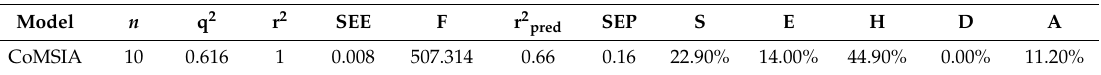
Table 3. Evaluation parameters and molecular field contribution rate of PAEs’ flammability, biotoxicity, and enrichment multi-e ff ect CoMSIA